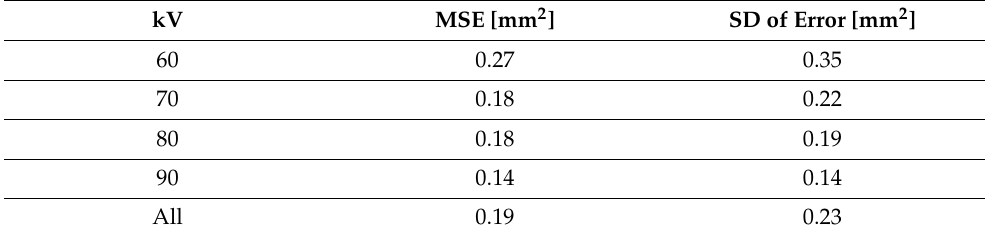
Table 2. Relationship between voltage and MSE of bone thickness measurements.